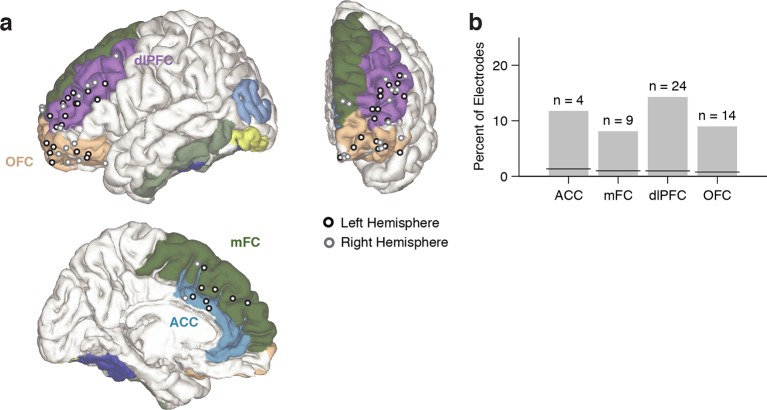
Electrode locations.(A) Location of conflict-selective electrodes (black/gray) shown on a reference brain, with each region colored (Materials and methods). Electrodes from the right hemisphere were mapped to the left hemisphere for display purposes. For more detail, see Supplementary file 2. (B) Percent of total electrodes in each region that were selective for conflict. Chance levels were computed using a permutation test (black line). The number of observed electrodes was significantly above chance for all regions (P < 0.01, permutation test, Materials and methods).DOI:
http://dx.doi.org/10.7554/eLife.12352.01010.7554/eLife.12352.011Figure 3—source data 1.Population gamma-power data.